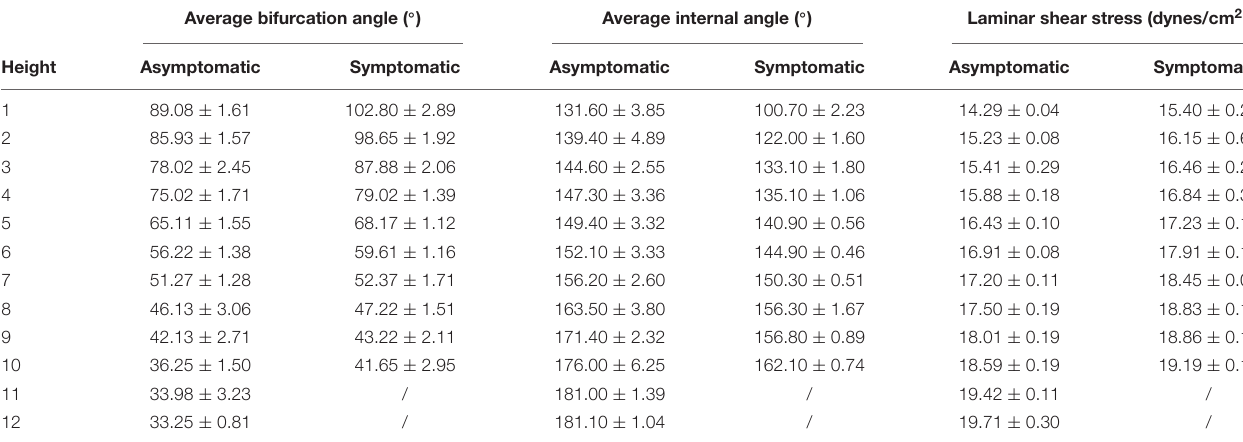
TABLE 4 | Relationship between height of the carotid bifurcation angle, internal carotid angle, and laminar shear stress.